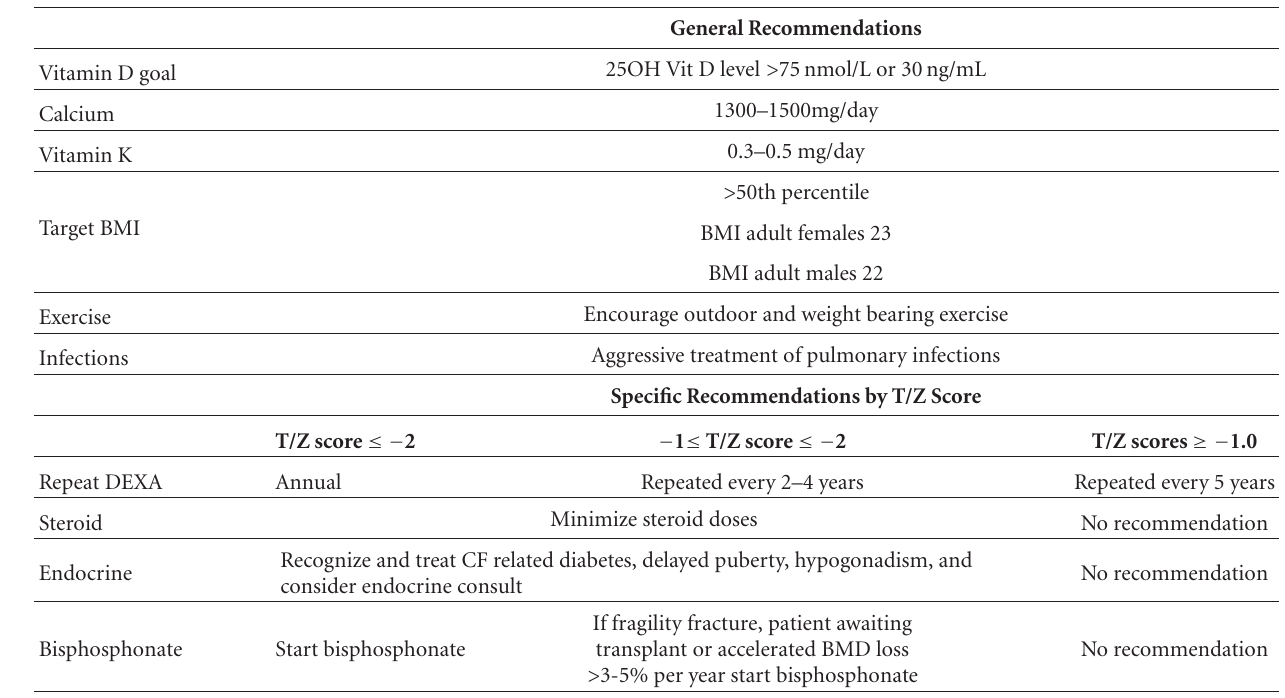
Table 2: Cystic fibrosis foundation guidelines for treatment of